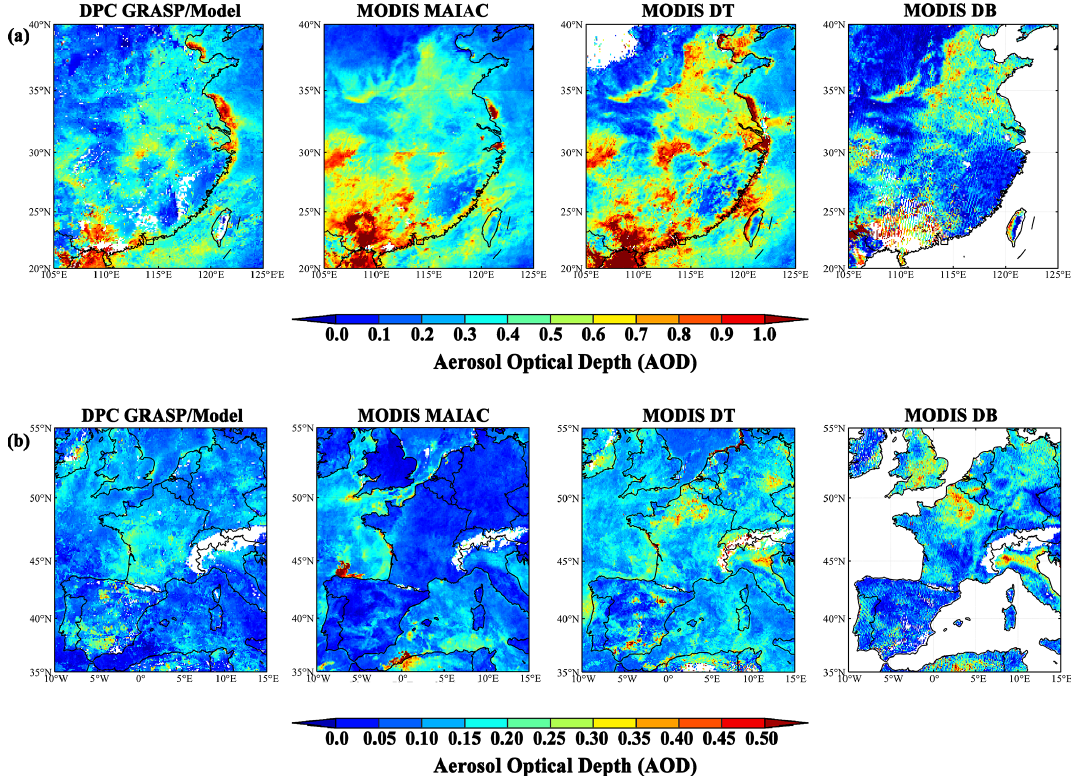
Figure 6. Spatial distribution of AOD from the DPC GRASP/Model scheme compared with MODIS MAIAC, DT, and DB aerosol products in March 2020: (a) eastern and southern China with its adjacent sea areas, (b) areas of western Europe including the Atlantic Ocean and the Mediterranean Sea. The DPC AOD is at 565nm, and the MODIS AOD is set at 550nm. Publisher’s note: Please note that the above figure contains disputed